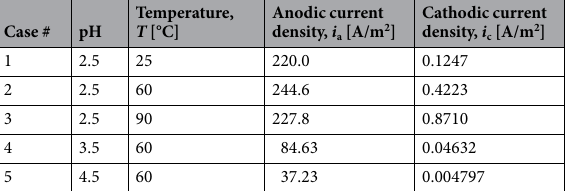
Table 2. Combinations of the pH of the electrolyte solution and temperature examined in the PF simulations of the general corrosion. Anodic and cathodic current densities at the applied potential of E = − 250 mV vs. SHE in each case are calculated by using Corrosion Analyzer software.